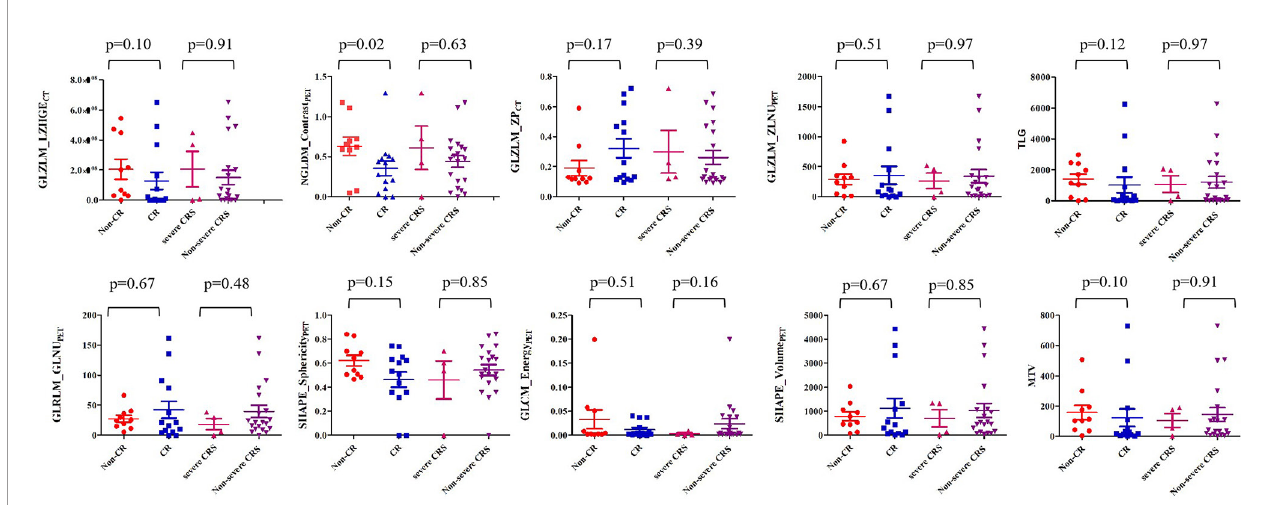
FIGURE 4 | Comparison of textural features between non-CR and CR patients and between severe CRS and non-severe CRS patients.